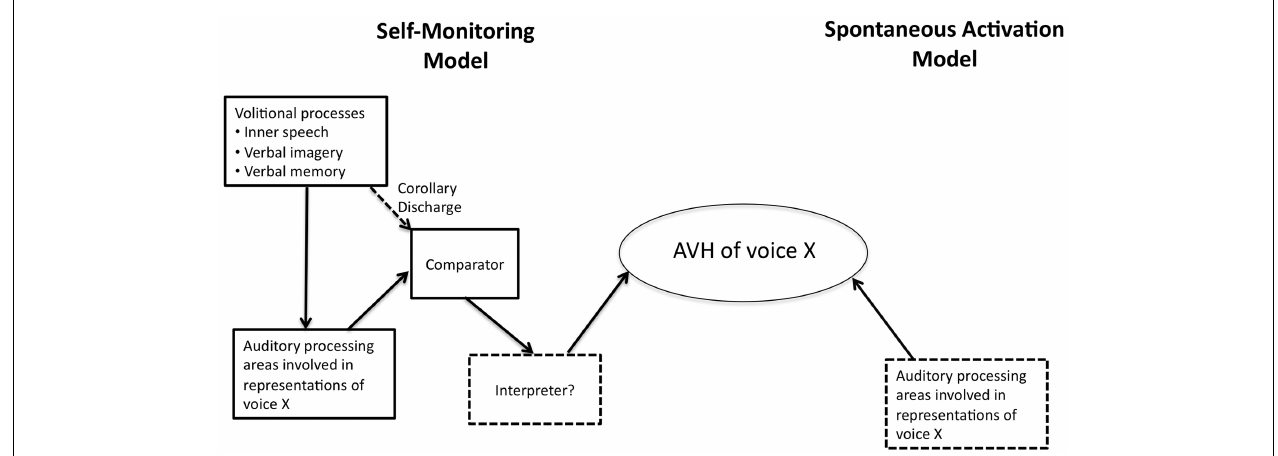
FIGURE 1 | Depiction of the two causal mechanisms for the generation of auditory verbal hallucination (AVH) .The self-monitoring model is more complex than the spontaneous activity